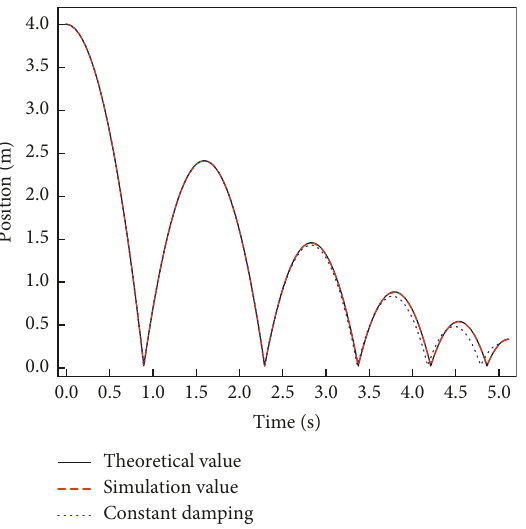
Figure 7: Velocity of centroid mass.